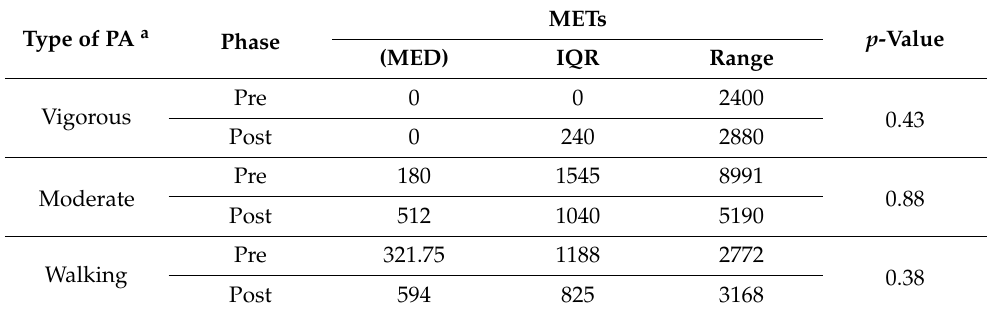
Table 2. Comparison of changes in the physical activity METs pre and post-Tele-Physical Activity promotion program.